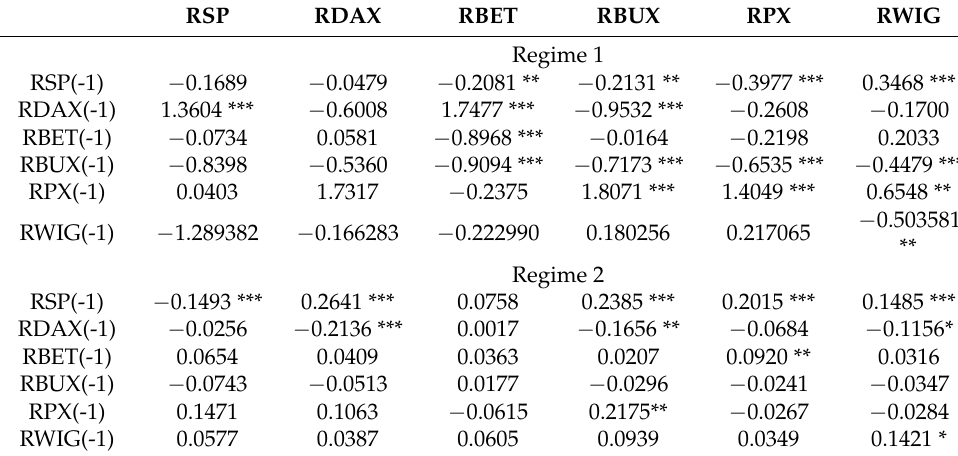
Table 7. Markov regime-switching VAR results.